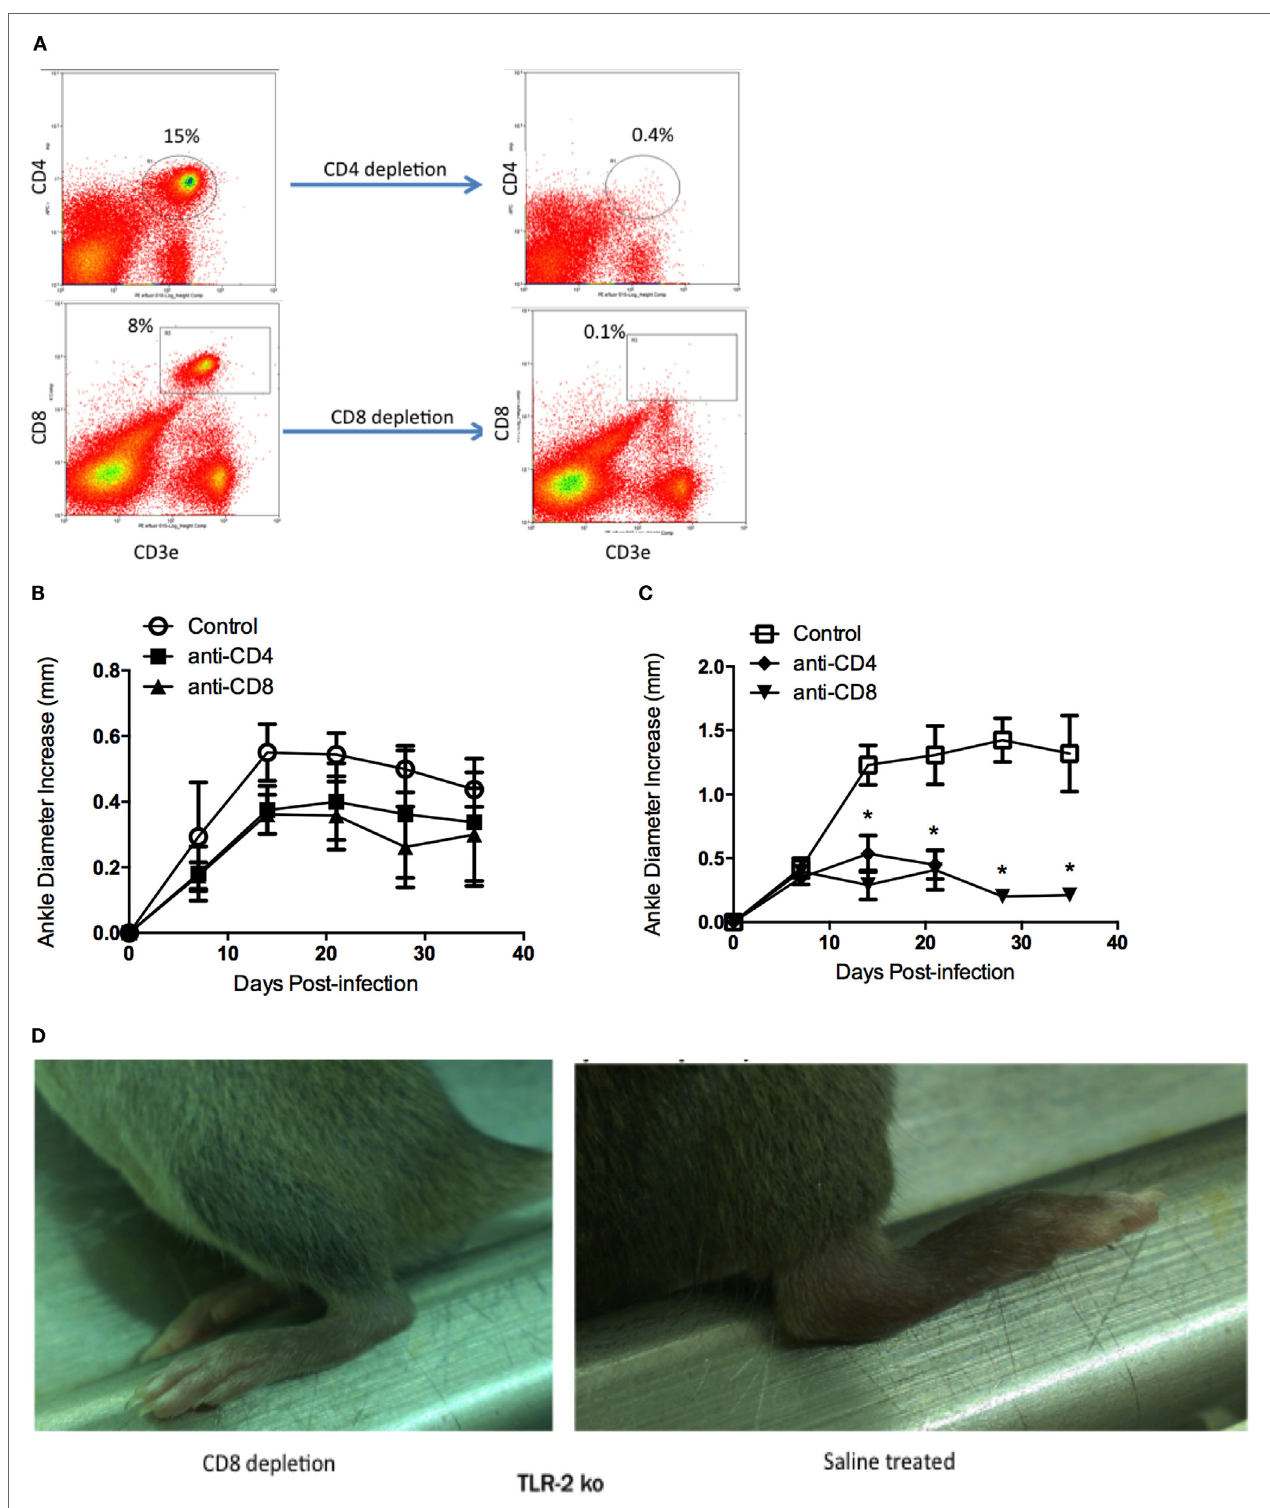
FigUre 4 | lyme arthritis in mice depleted of cD4 or cD8 T cells . Mice were treated with saline (control), CD4-depleting antibody, or CD8-depleting antibody and infected with B. burgdorferi . Flow cytometry plots demonstrate depletion of CD4 + and CD8 + T cells 6 days posttreatment (a) . Arthritis development was monitored over time for WT (B) and TLR2 − / − (c) mice. Representative pictures of TLR2 − / − mice depleted of CD8 T cells or saline treated were taken at day 14 postinfection (D) . Data are representative of two separate experiments. n = 3, symbols represent means ± SD. * p > 0.01 compared to WT control from same time